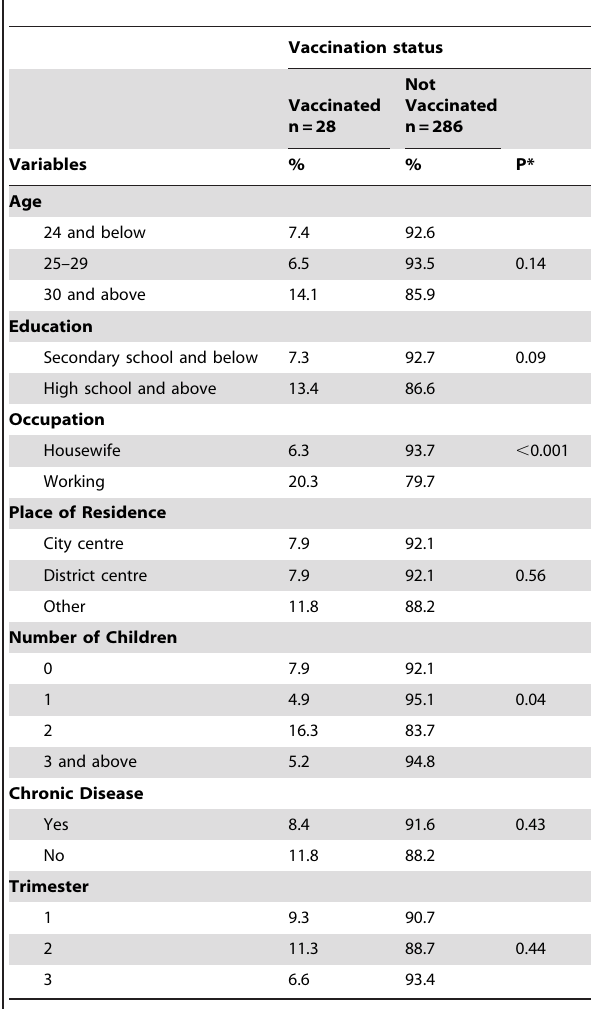
Table 1. The affect of sociodemographic characteristics on the 2009 H1N1 vaccination status of pregnant